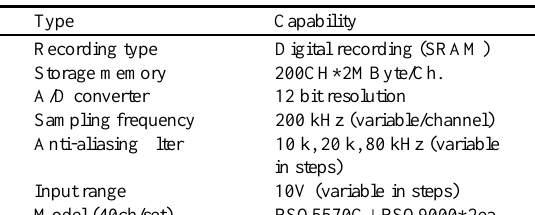
Table 3 Characteristics of recorder